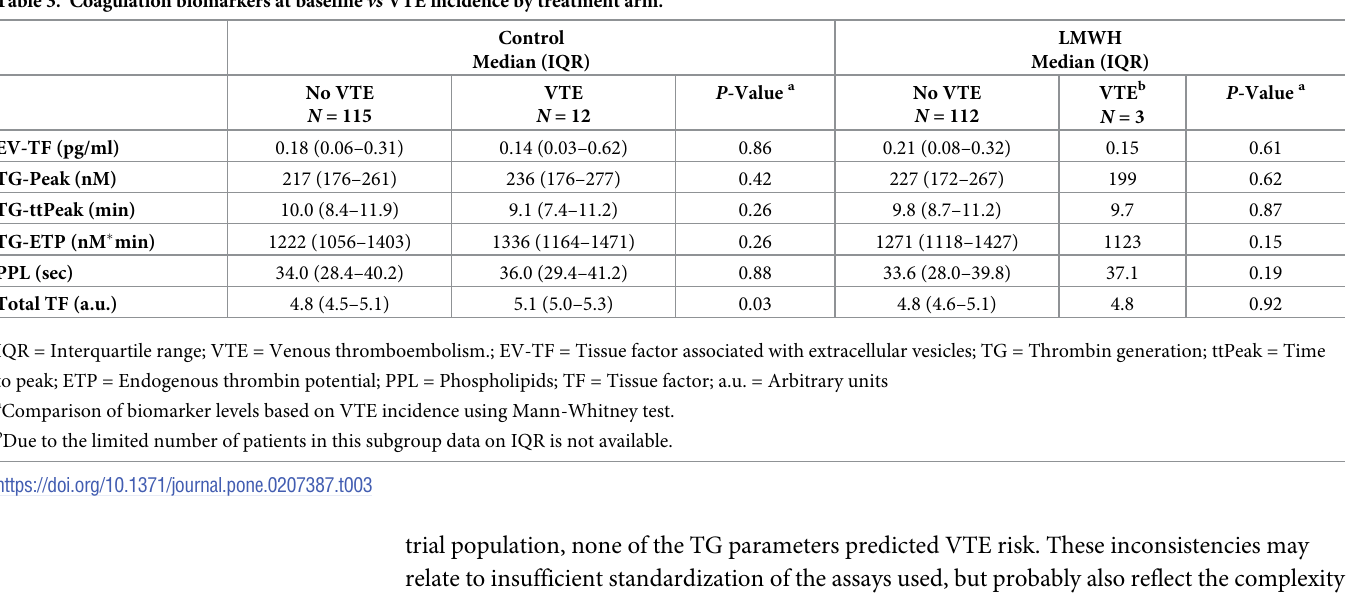
Table 3. Coagulation biomarkers at baseline vs VTE incidence by treatment arm.